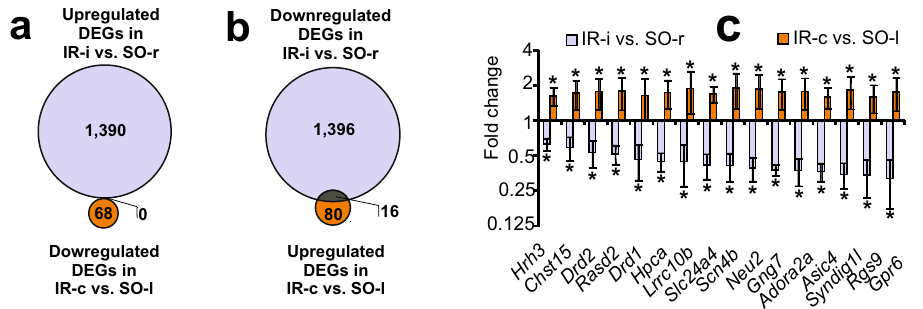
Figure 3. Comparison of RNA-Seq results in the CH and IH relative to the SO rats showed an opposite directionality of changes in gene expression in two rat brain hemispheres at 24 after tMCAO. ( a , b) Schematic comparisons of the results obtained in pairwise comparisons for IR-i vs. SO-r and IR-c vs. SO-l are represented by Venn diagrams. Comparison of only the upregulated DEGs for IR-i vs. SO-r and downregulated DEGs for IR-c vs. SO-l ( a ), and downregulated DEGs for IR-i vs. SO-r and upregulated DEGs for IR-c vs. SO-l ( b ) are shown. The cutoff for gene expression changes was 1.50-fold. Only those genes with Padj < 0.05 were selected for analysis. C . Sixteen DEGs that were downregulated for IR-i vs. SO-r and, conversely, upregulated for IR-c vs. SO-c are presented and were shown to lie within the intersection of the gene sets on the Venn diagram ( b ). Data are presented as the mean ±